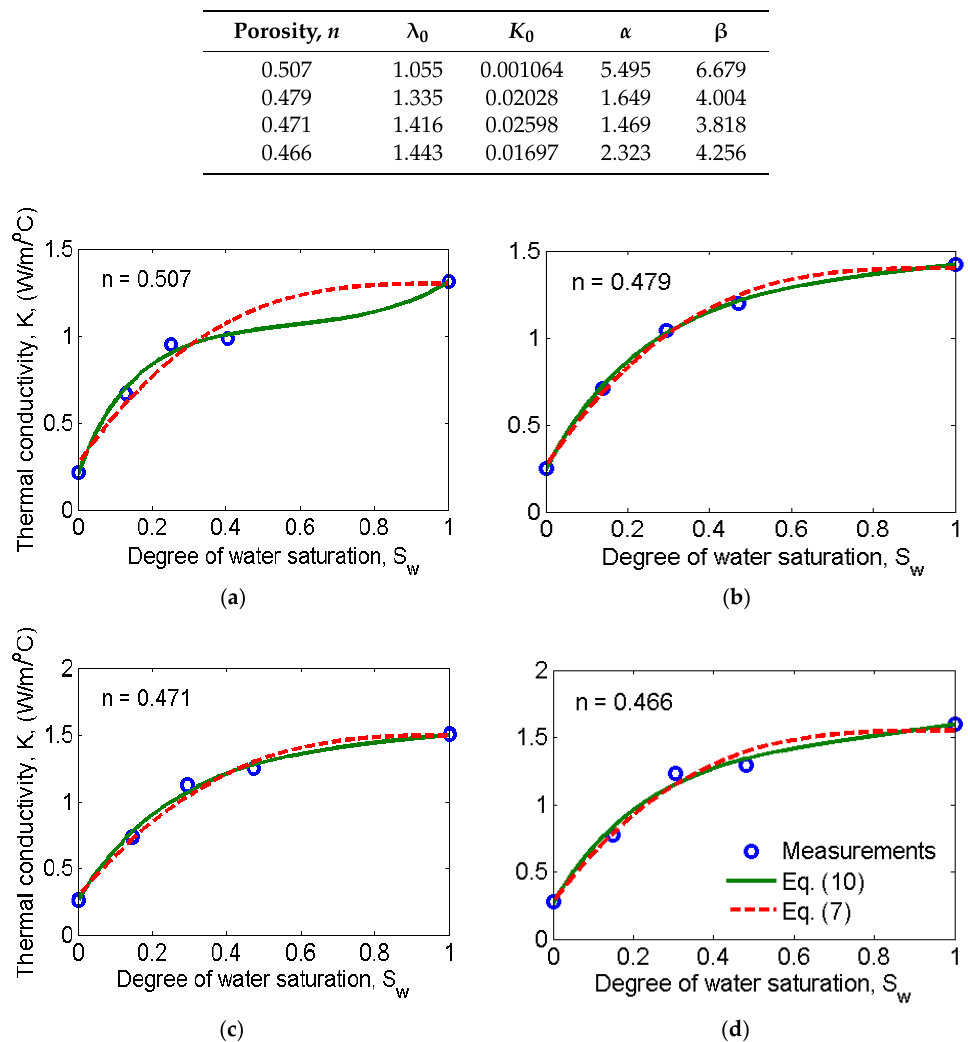
Figure 11. The Modelling Results using Equations (4) and (15), ( a ) porosity n = 0.507; ( b ) porosity n = 0.479; ( c ) porosity n = 0.471; ( d ) porosity n = 0.466.